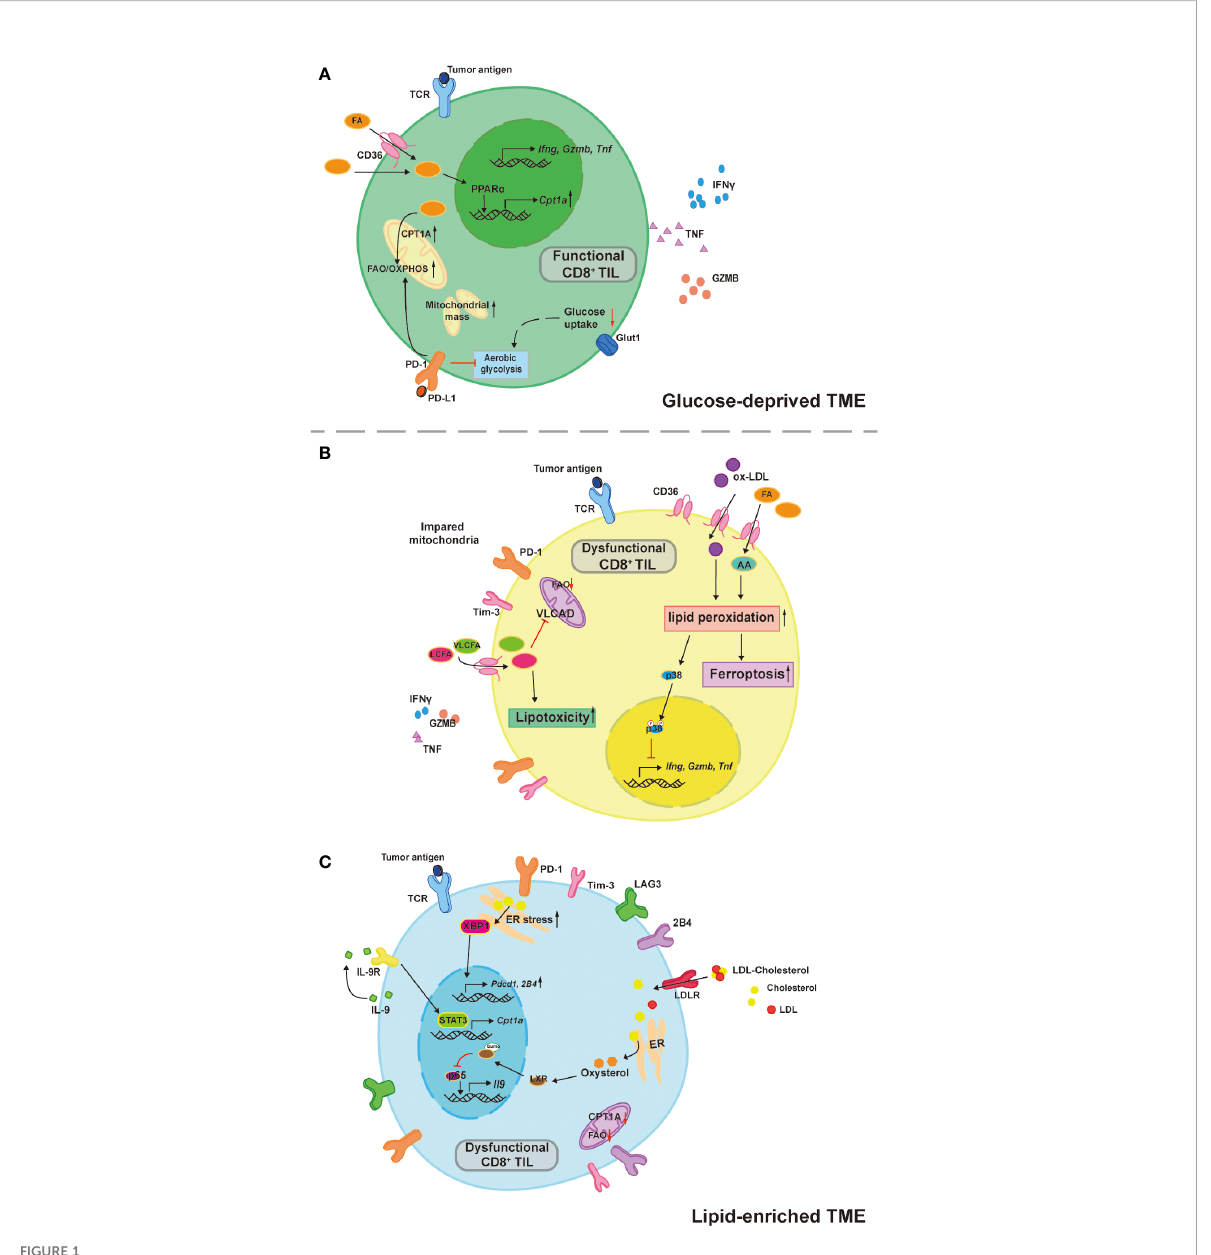
FIGURE 1 TME lipids dictate CD8 + TILs functional heterogeneity. (A) CD8 + TILs utilize aerobic glycolysis to support their antitumor effects, which is inhibited in a glucose-deprived TME. Instead of relying on glucose, CD8 +TILs upregulate PPAR a -mediated CPT1A expression in response to the environmental FAs and the FAO is therefore increased to compensate the energy de fi cit. This compensatory circuit is further reinforced by PD-1 signaling due to its inhibitory effects on aerobic glycolysis. (B) Increased uptake of TME FAs and oxidized lipids by CD36 drive CD8 + TILs dysfunction. Both Arachnoid acid (AA) and oxidized low density lipoprotein (ox-LDL) induce abnormal cell death by ferroptosis, ox-LDL also increases p38 phosphorylation, which inhibits the transcription of effector cytokines like TNF a and IFN g . LCFAs and VLCFAs poison CD8 + TILs through lipotoxicity and inhibit the VLCAD expression that in turn accelerates the accumulation of LCFAs and VLCFAs. (C) Tc9 cells are resistant to lipid peroxidation and ferroptosis by its IL-9 autocrine-mediated STAT3/FAO pathway, which is impaired in the cholesterol-enriched TME. Oxysterol promotes the sumoylation of LXR that inhibits the p65 binding on IL-9 promoter and therefore decreased expression. Moreover, cholesterol accumulation in the cytoplasm promote ER stress sensor (XBP1) expression to directly induce inhibitory receptor expressions including PD-1 and